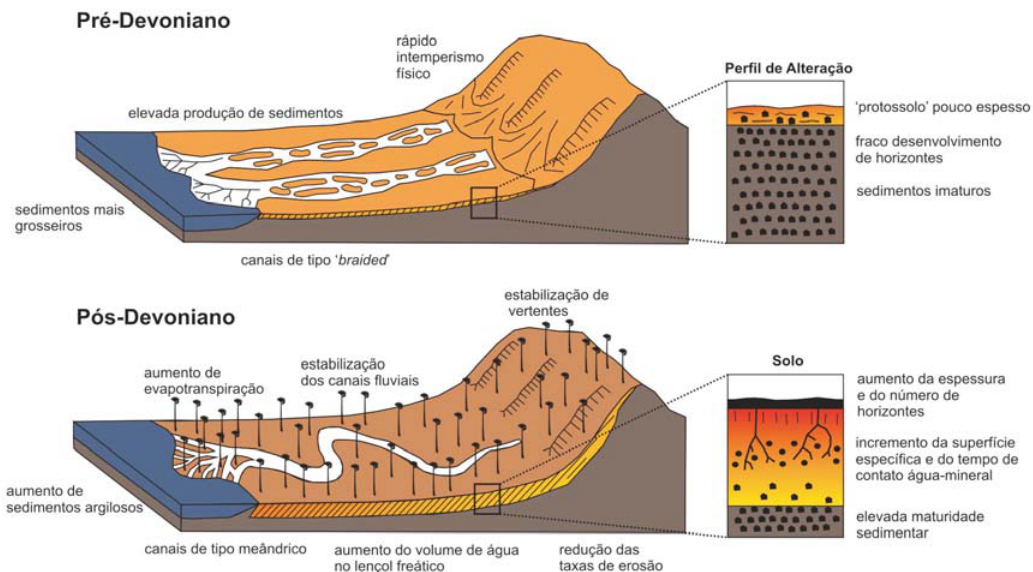
Figura 2. Alterações no ciclo hidrológico e nos processos de alteração pedogenética decorrente da colonização da superfície terrestre pelas plantas vasculares. Fonte: adaptado de Algeo et al.